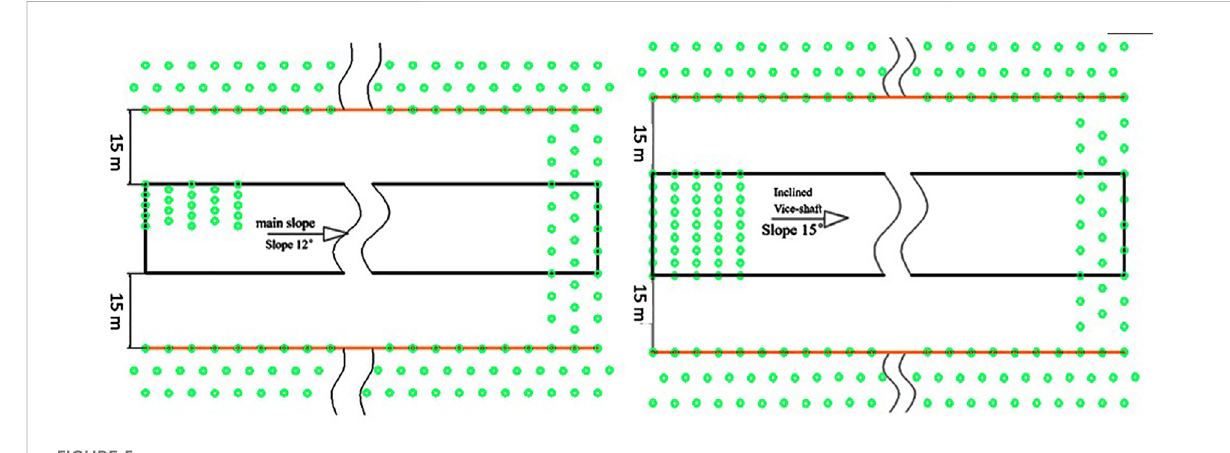
FIGURE 5 Plan layouts of the curtain grouting holes of the main and auxiliary